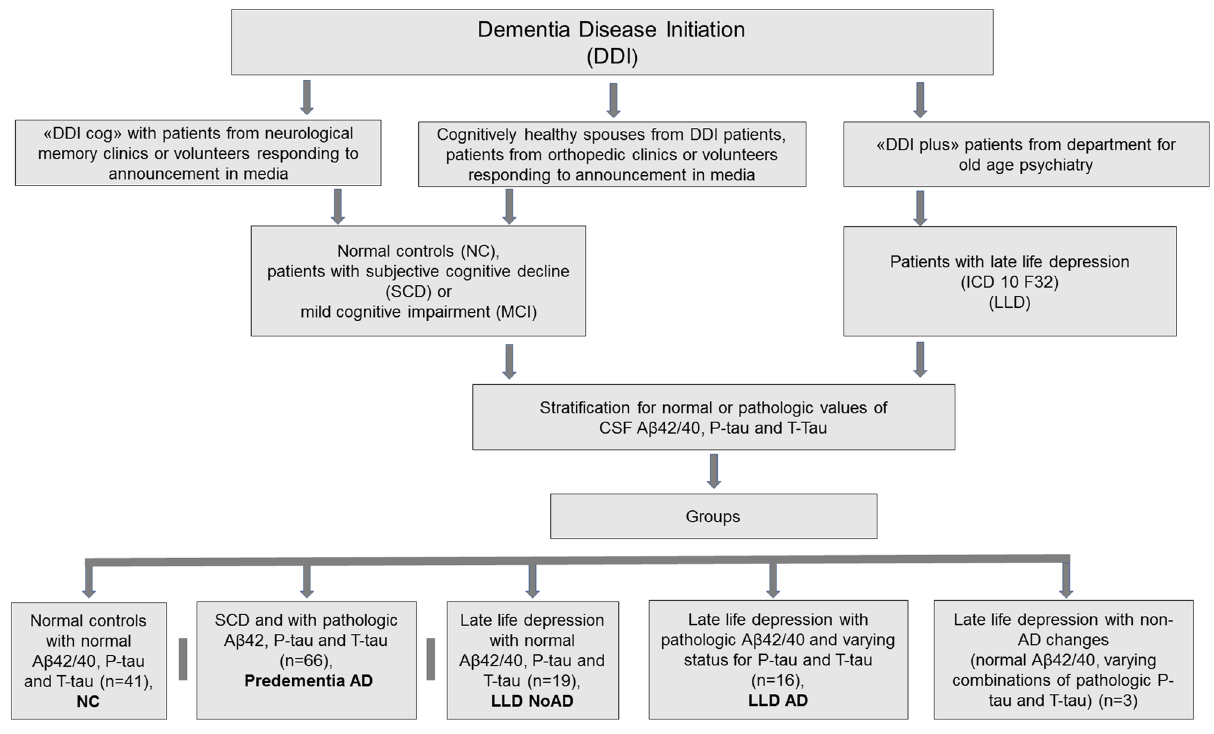
Figure 1. Inclusion of participants and groups. Normal AD biomarkers “LLD NoAD”